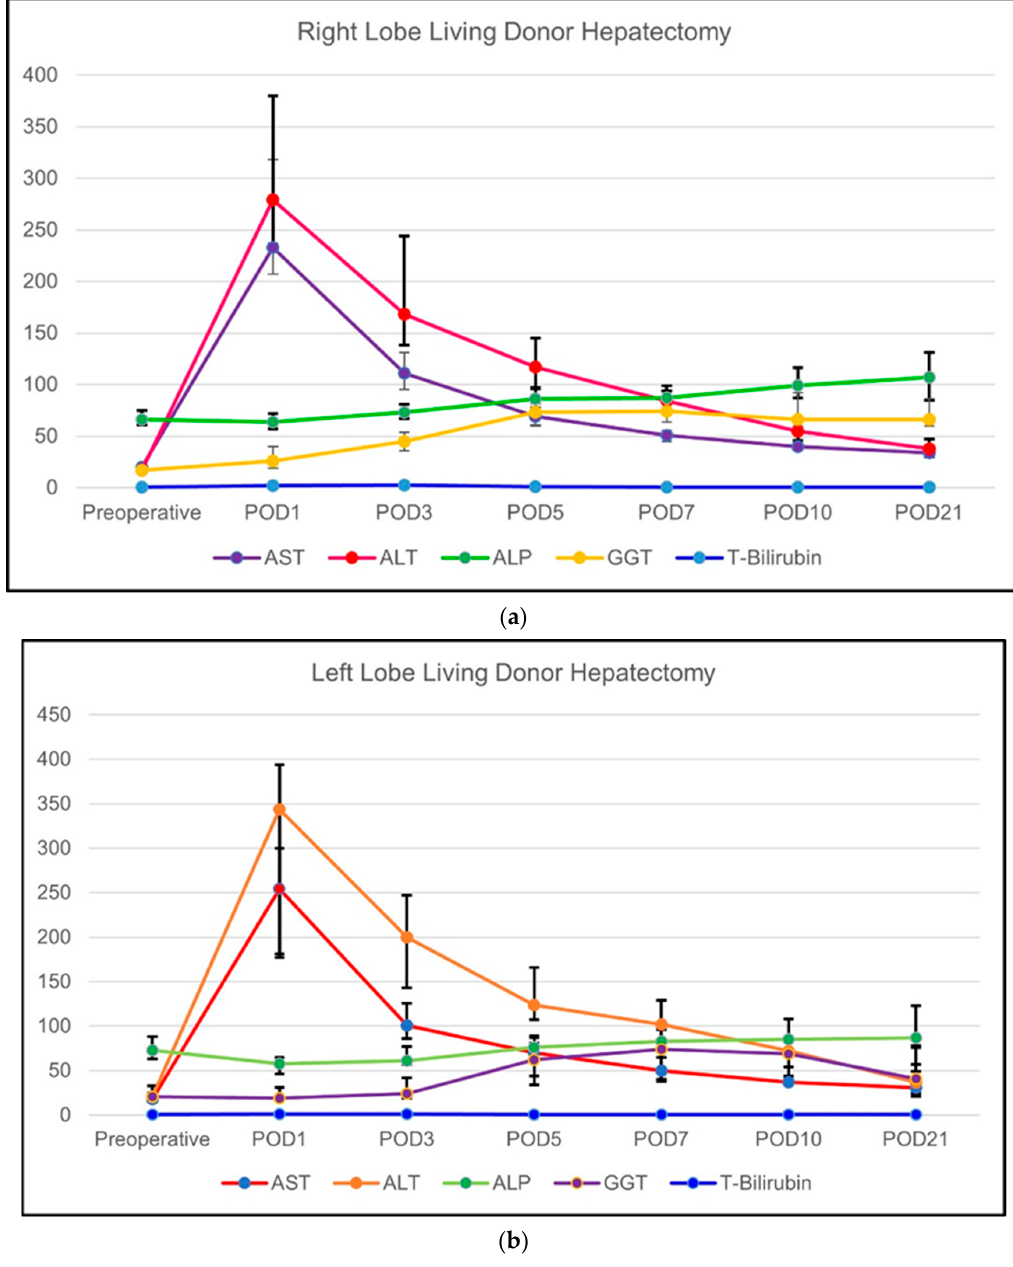
Figure 2. ( a ) The course of routine biochemical blood parameters of LLDs who underwent right-lobe LDH; and ( b ) the course of routine biochemical blood parameters of LLDs who underwent left (including left lateral segment)-lobe